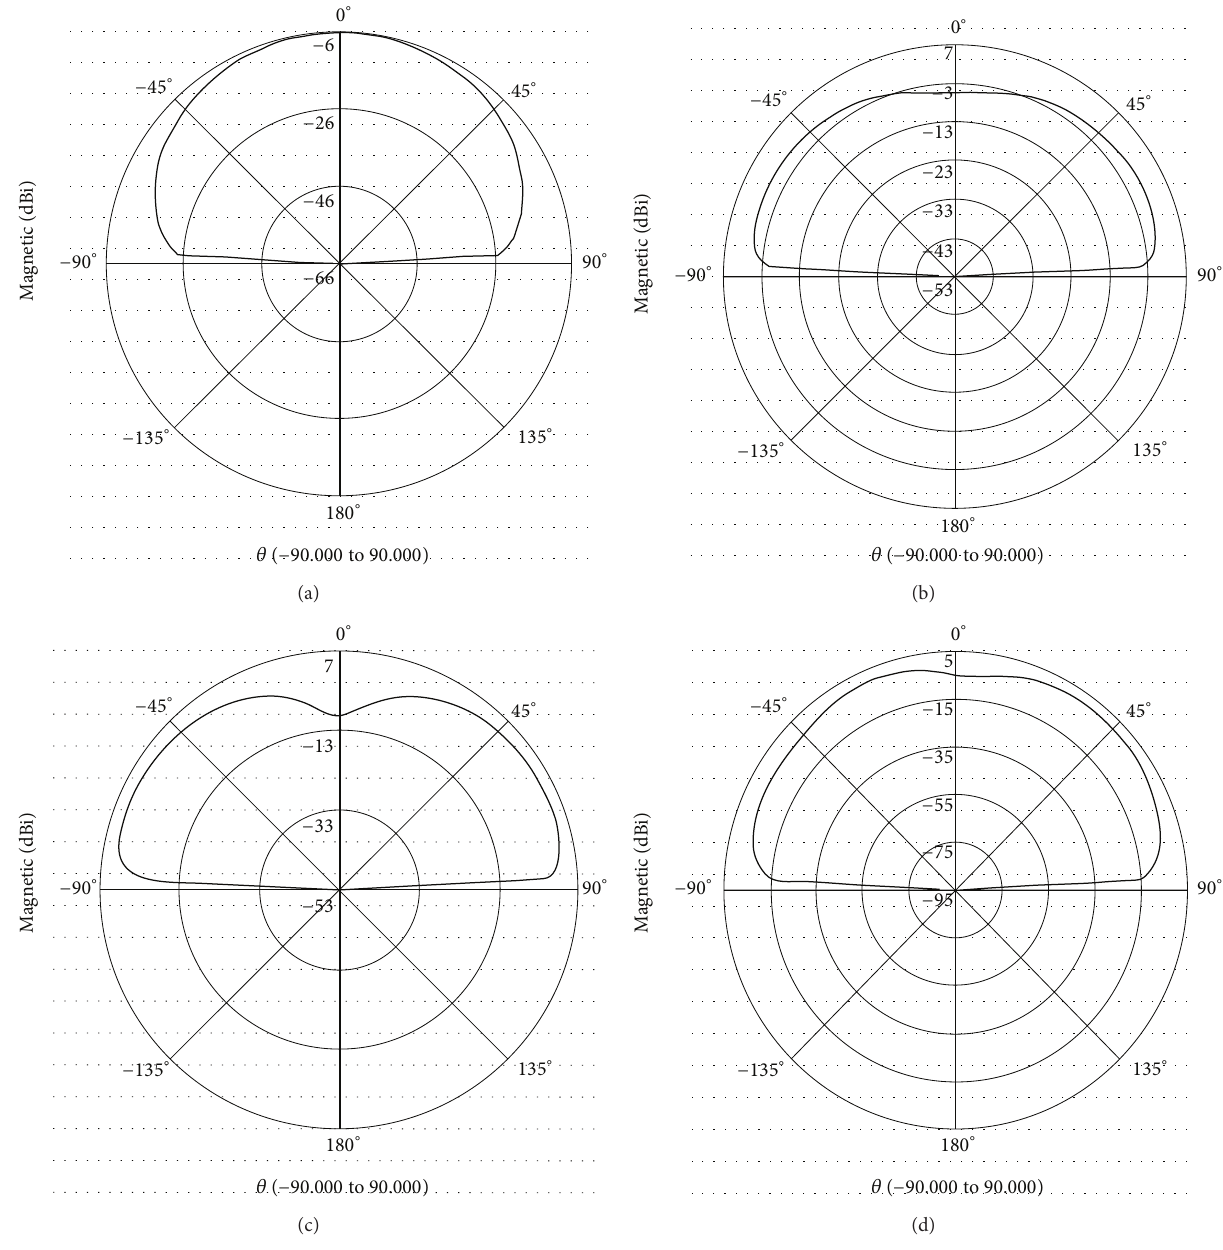
Figure 13: Simulated two-dimensional (2D) radiation gain patterns of the proposed antenna composed of six unit cells in elevation plane ( Φ = 0 ∘ ) and at operation frequencies: (a) at 4.3GHz, (b) at 6GHz, (c) at 9GHz, (d) at